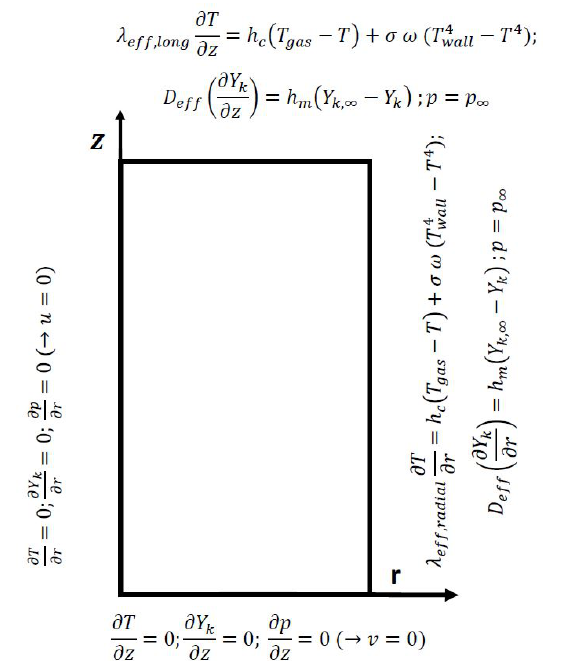
Figure 1. Computational domain and applied boundary conditions. The z-axis marks the wood log length, and the r-axis marks the wood log radius. The velocity v in the figure is the same as u z in the equations, and u is the same velocity as u r in the